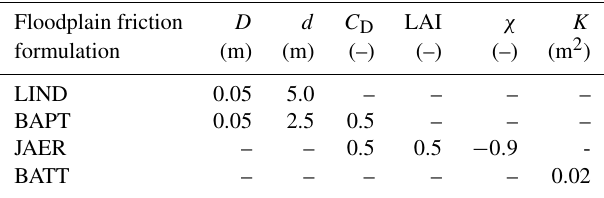
Table 1. Floodplain friction parameter values calibrated under emergent conditions ( H = 10 . 0m).